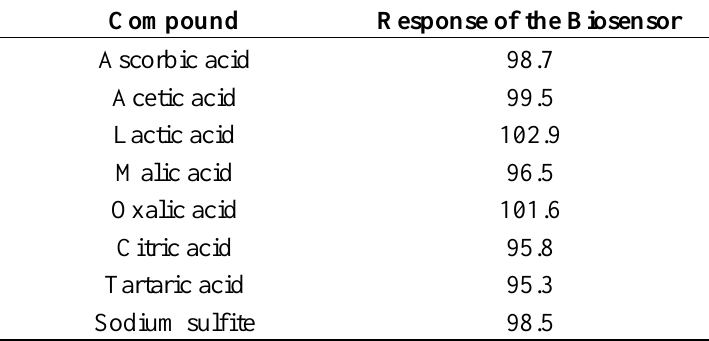
Table 3. Interference of some compounds; % ratio 2:1 interference (2% v/v): ethanol (1% v/v), on the response to ethanol of AOX/PANI biosensors.